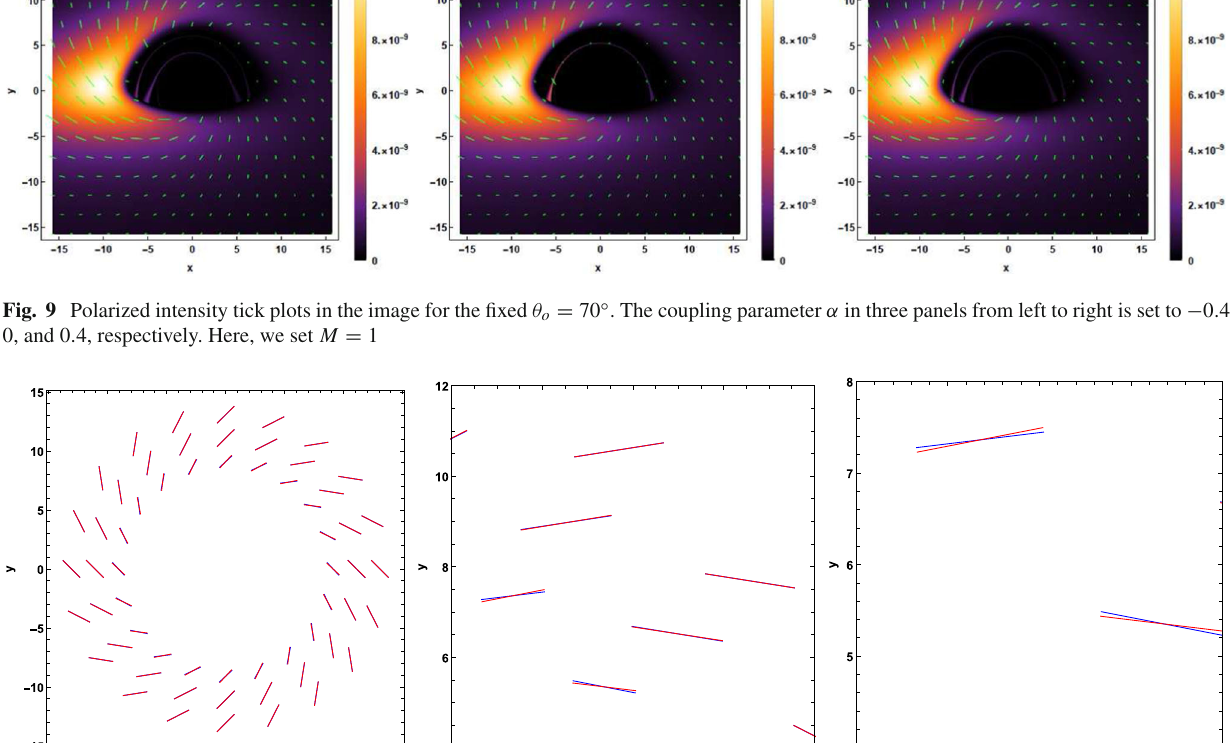
maximum intensity depends on the inclination angle θ o of the observer. As θ o = 0 ◦ , the maximum intensity of the sec- ondary image is almost independent of the coupling param- eter α . As θ o = 70 ◦ , it is an increasing function of α for the PPL and a decreasing function for the PPM.The width of the